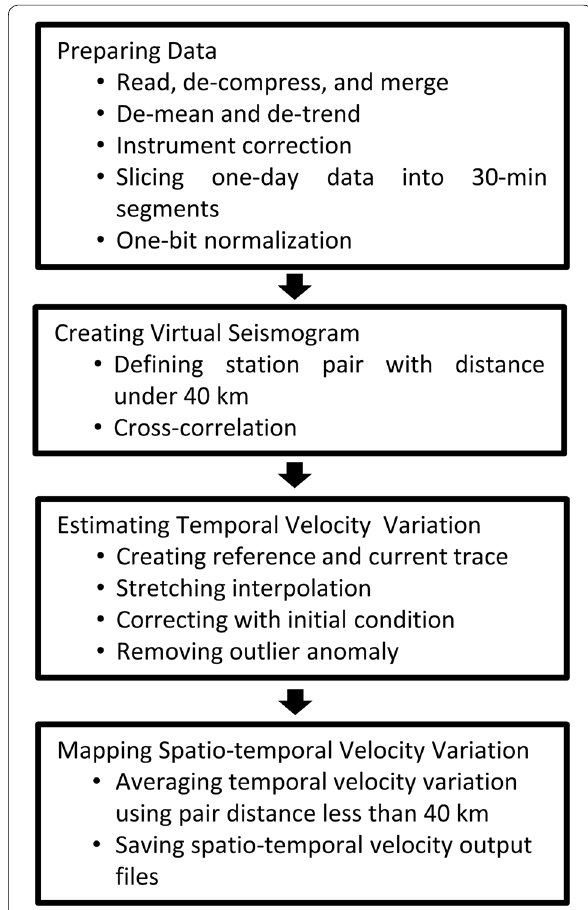
Fig. 1 Data processing workflow diagram for estimating spatio-temporal velocity